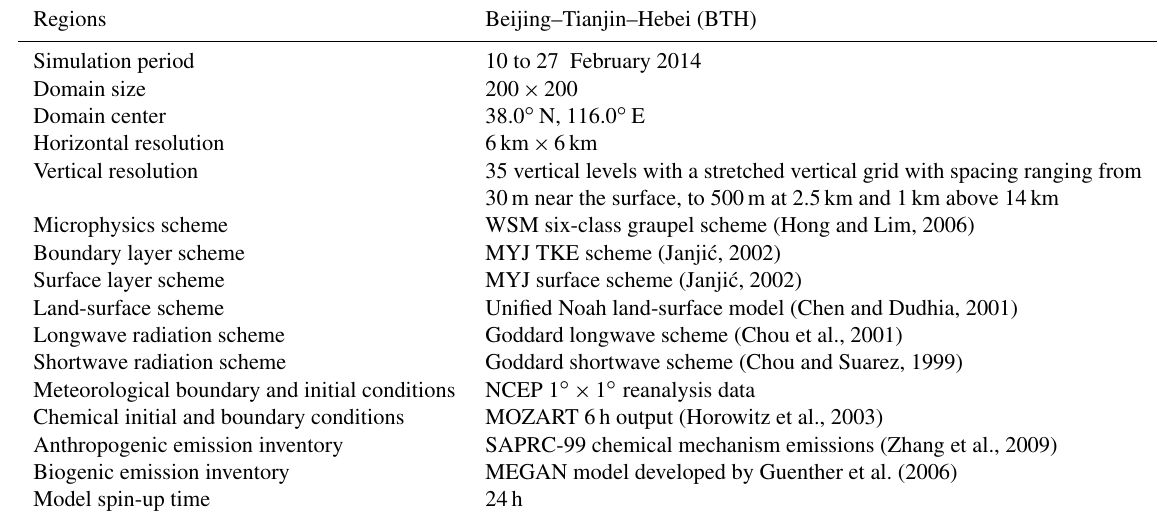
Table 1. WRF-Chem model configurations.